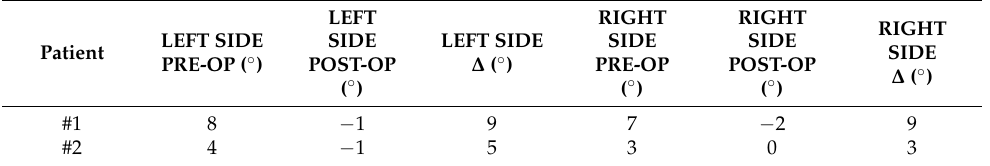
Table 2. Summary of the pre and post treatment angles and the overall variation ( ∆ ), per side. Unit of measure: grade ( ◦ ). Positive angles are formed by masseteric lines lateral to the zygomatic arch line. Negative angles are when the masseteric line falls medial to the perpendicular zigomatic arch